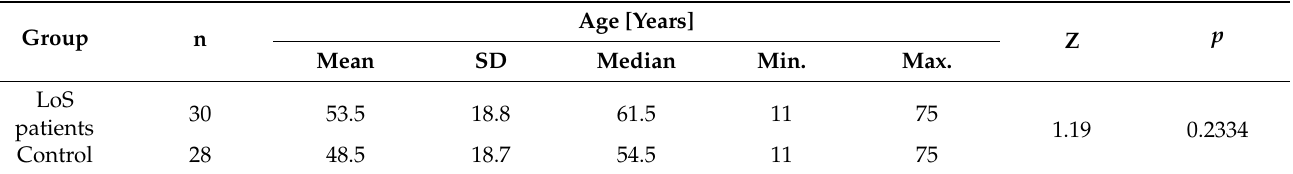
Table 2. Age structure of LoS patients and HCs.